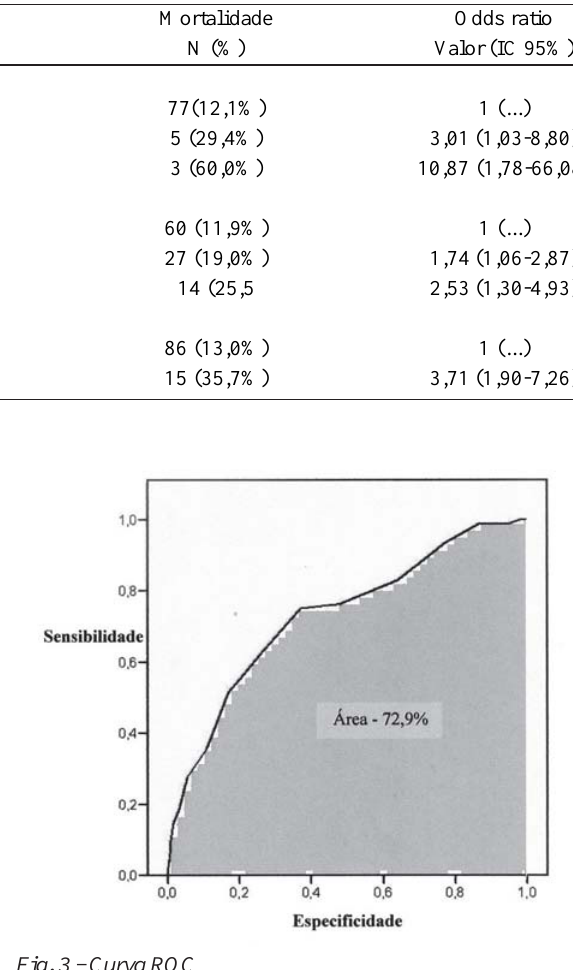
Tabela 2. Preditores de risco e mortalidade quanto a fatores